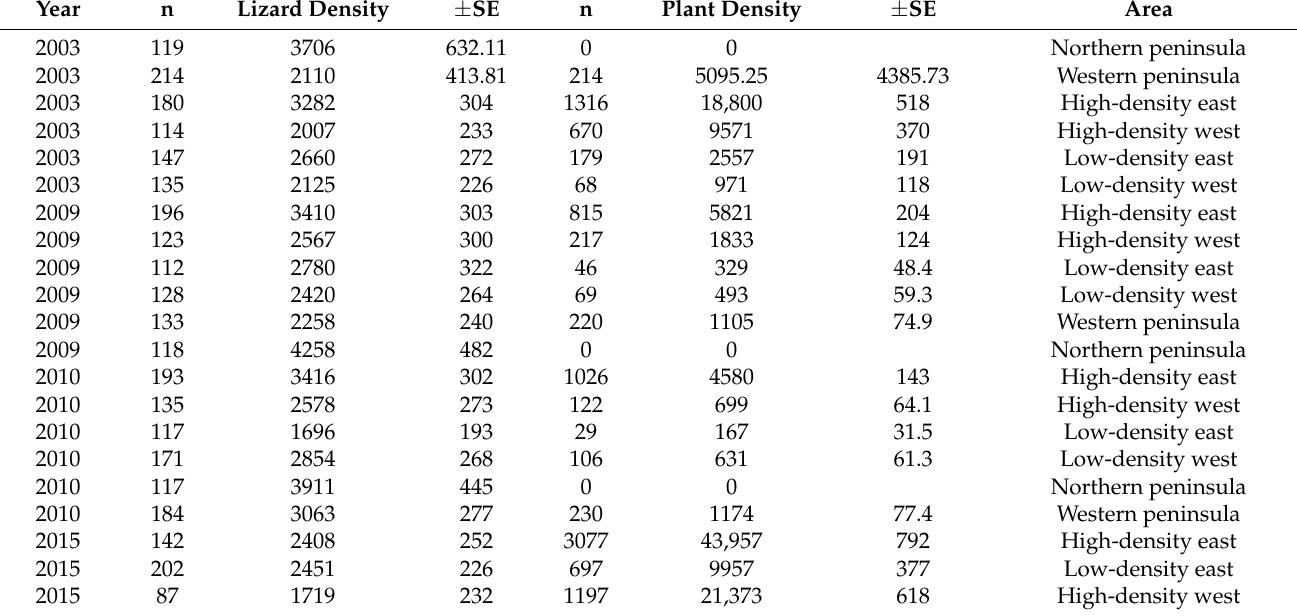
Table A2. Annual variation of lizard and dead horse arum densities at different areas of Aire Island. In some years and areas, line transects were performed without any contact with plants. For lizard and plant densities, we show the number of contacts (n) and the density (number of individuals per hectare ± SE). Densities were separately estimated for eastern and western parts (east or west from the main track of the island) of high-density and low-density areas, as well as for the eastern area of the island. Due to logistic reasons, in 2018, we did not obtain plant densities for the high-density area (see more details in the